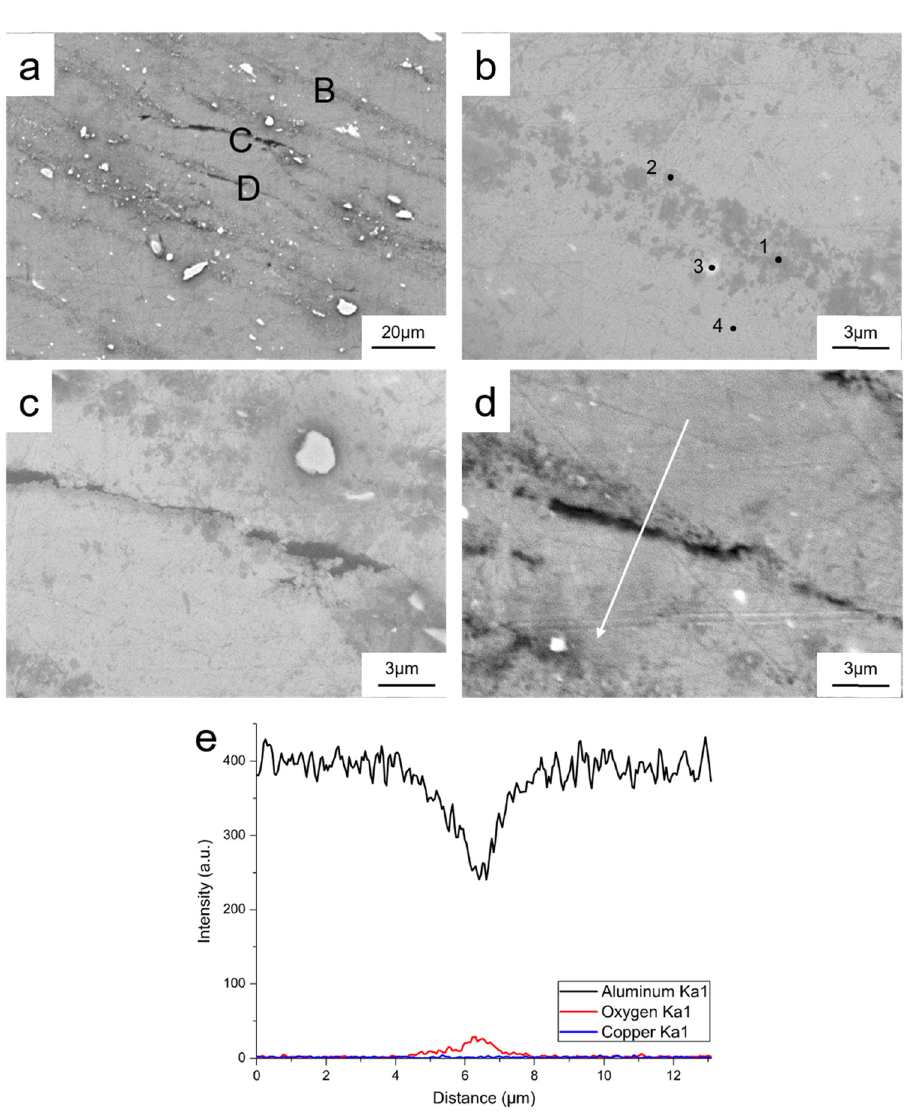
Figure 5: ( a ) SEM surface morphology of JLR at region A in Figure 2 ( d ) ; ( b ) – ( d ) magni fi cation of B, C, and D in ( a ) ; ( e ) EDS analysis along the white arrow in ( d ) .